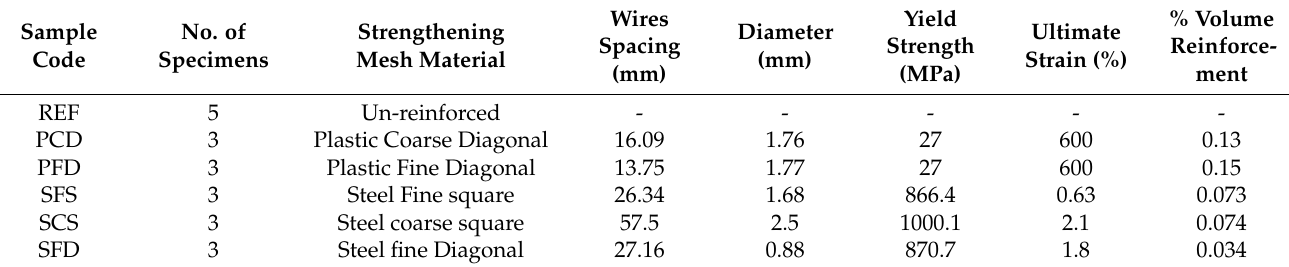
Table 1. Summary of the strengthening scheme.